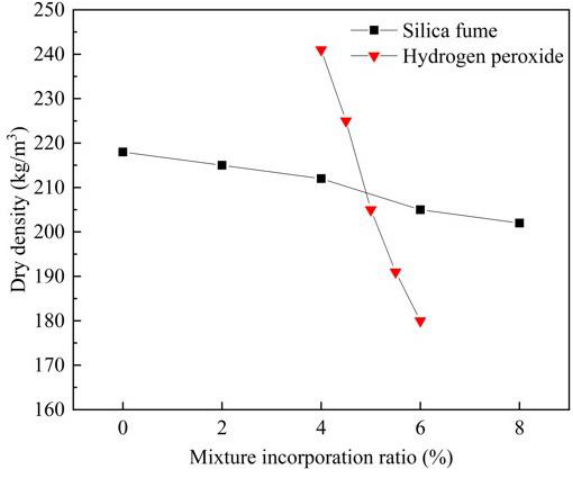
Figure 2. Relationship between dry density and silica fume and hydrogen peroxide dosage.